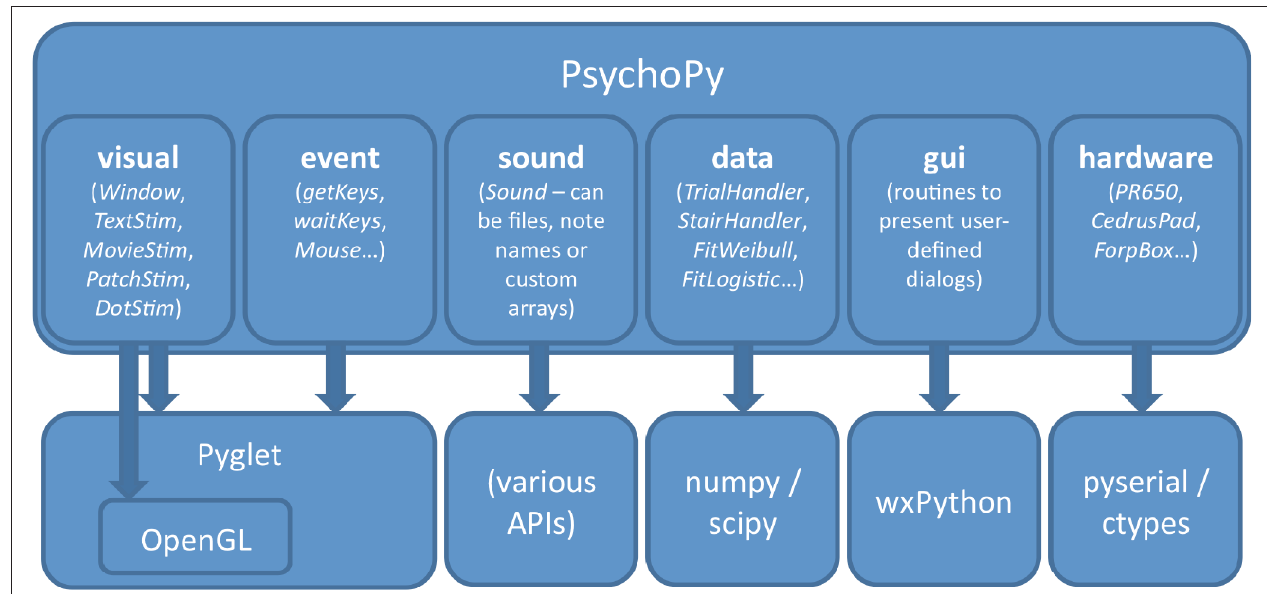
FIGURE 2 | The structure of PsychoPy. PsychoPy comprises a number of sub-modules for controlling different aspects of an experimental setup, from stimulus presentation to analysis of data. In turn these use a number of dependent libraries, that typically have a very good degree of platform-independence.